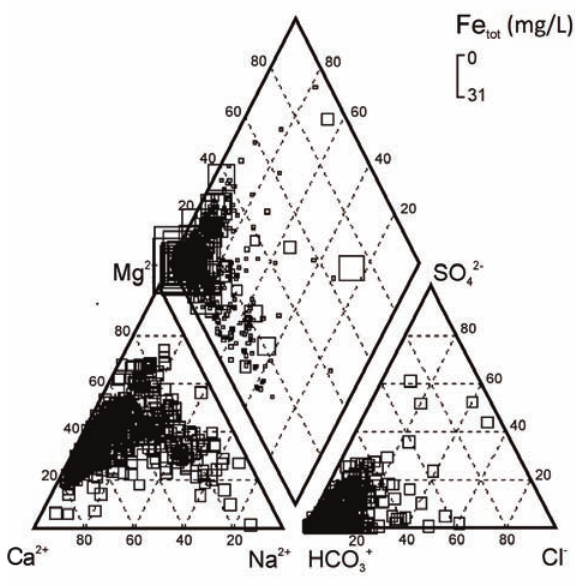
Fig. 3. Piper diagram showing the content of Fe tot as a function of the water type in the Middle Devonian aquifer system. The size of a rectangle refers to Fe tot concentration.